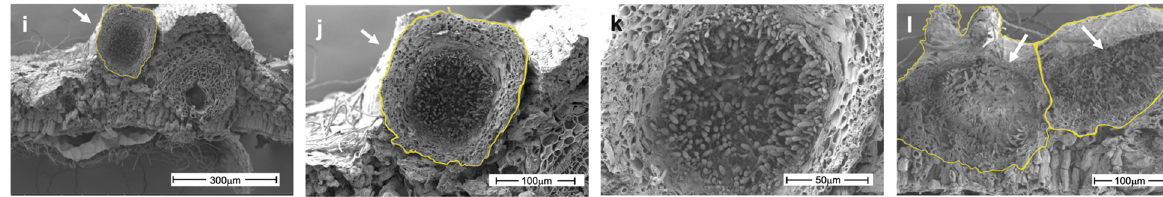
Figure 4. Analysis by scanning electron microscopy of L. styraciflua leaves infected with N. parvum . ( a , c ) Control adaxial leaves at 3 and 8 dpi, respectively. ( b , d ) Infected axial leaves at 3 and 8 dpi, respectively. ( e ) Leaf base infection: the dashed squares indicate the zones that were analyzed in ( f – l ). ( f , h ) Control at 3 and 8 dpi, respectively. ( g ) Infected sample at 3 dpi. ( i – l ) Infected sample at 8 dpi. ( j , k ) Close ‐ ups of panel ( i ). The pycnidia are delimited with a solid yellow line. Arrows indicate the pycnidium and conidia of N. parvum .